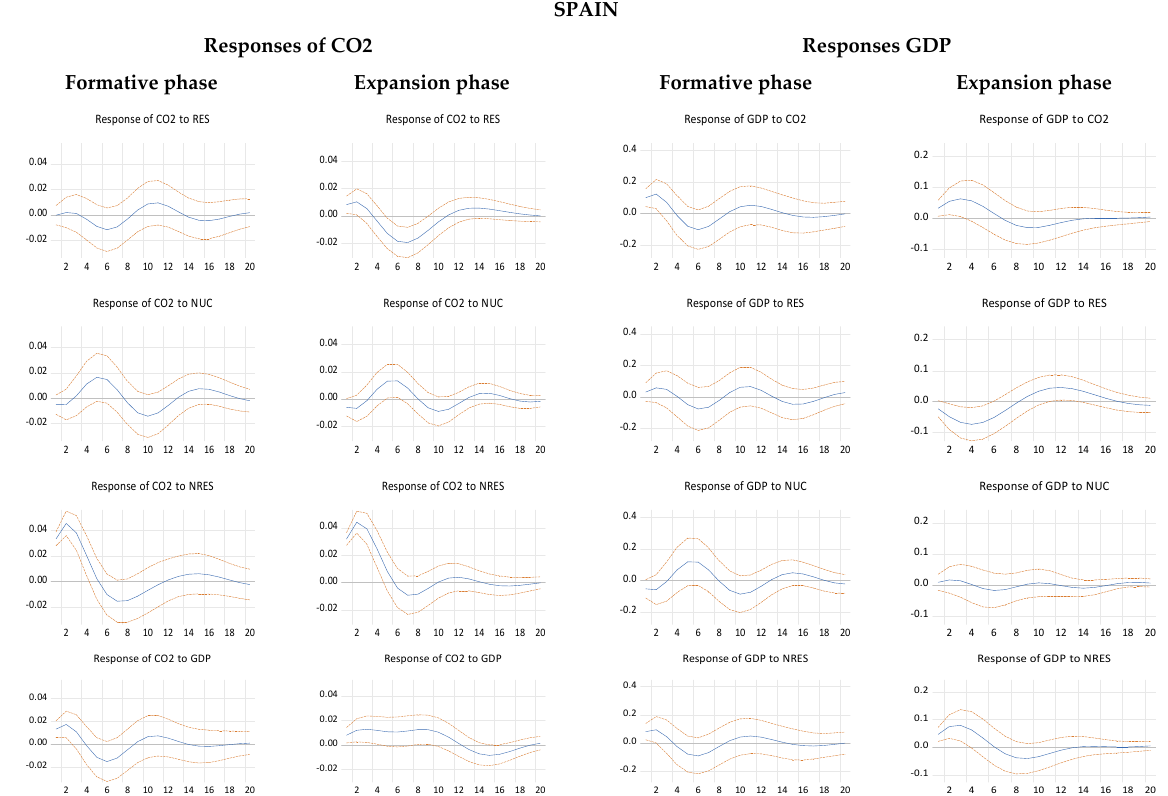
Figure 2. Responses of CO 2 emissions and GDP to shocks in another variables in formative and expansion phases in France.